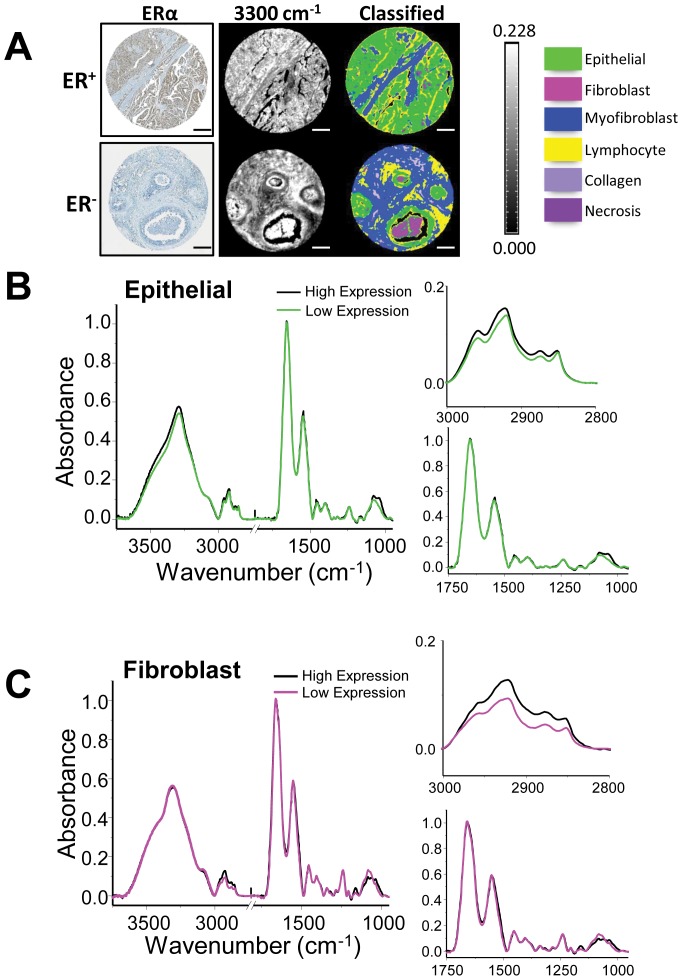
Spectroscopic signatures determined using 3D co-culture models can be translated to human breast tissue samples.(A) Tissue microarray (TMA) biopsy cores (1.5 mm core diameter) were IHC stained for ERα and also imaged using FT-IR imaging (N-H/O-H band at 3300 cm−1 visualized here for clarity). Images classified using Bayesian classifier are displayed as well to highlight the ability of FT-IR to discriminate between cell types in complex samples. Scale bar represents 250 µm. (B) Differences between epithelial pixels in patient samples with high (>80%) and low (<20%) expression of ERα can be seen in peaks at 1080 cm−1 (phosphate) and 1030 cm−1 (glycosidic bonds). Interestingly, there are more apparent differences in these peaks when pixels from fibroblasts are analyzed. Full spectrum (3800 – 950 cm−1), C-H stretching region (3000 – 2750 cm−1), and biochemical fingerprint region (1750 – 950 cm−1) are shown.